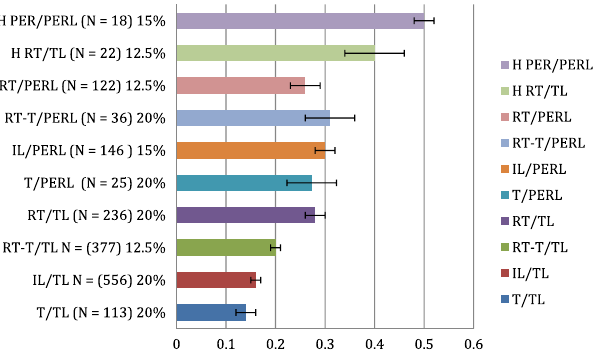
FIG. 2. Calculus-based FCI normalized gain by laboratory and teaching style. The data are listed by laboratory/teaching style ( N ¼ number of students ) percentage total grade allotted to laboratories plus recitation . Lab styles are labeled by traditional (T), Real Time Physics (RT), combination RT and T (RT-T), developed at the University of Illinois (IL), and locally written PER-informed (PER). The lecture teaching styles are labeled by traditional lecture (TL), PER-informed lecture (PERL), and inquiry-based instruction (INQ). Honors sections are labeled with an H